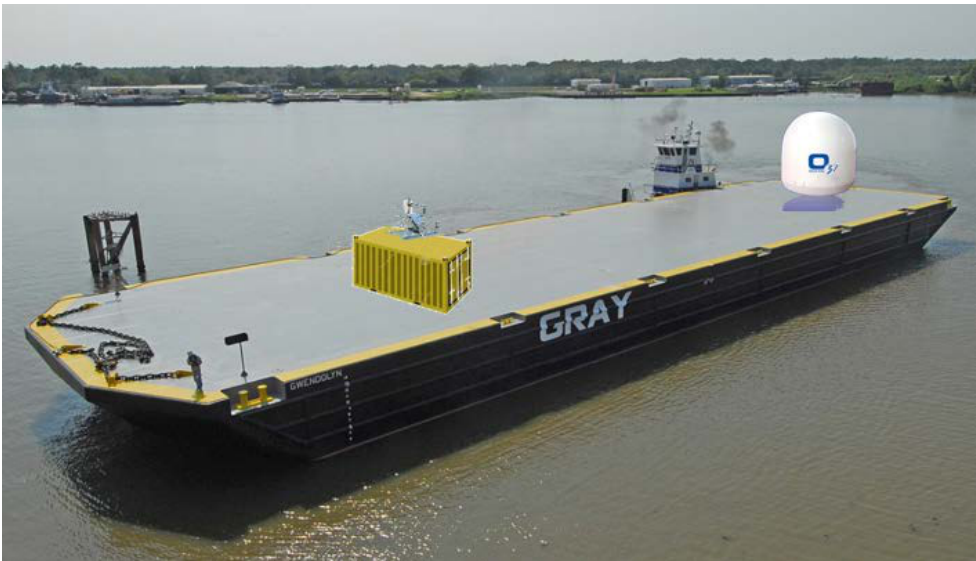
Figure 10. Autonomous multibeam sonar barge would be controlled and transmit data through telepresence and could become platform for many oceanographic and atmospheric measurements and maintain long-endurance at sea with relatively little cost.